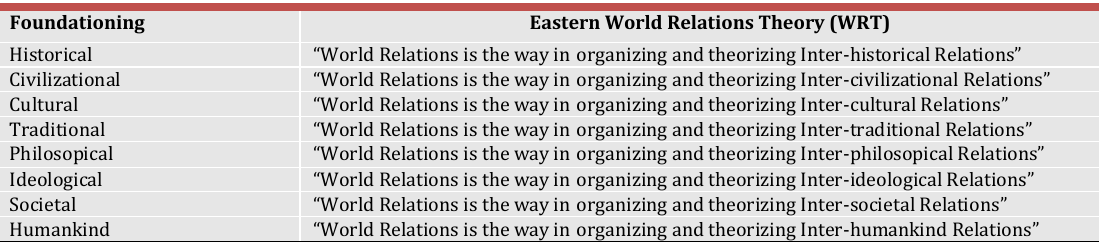
Table 3 Meaning of Eastern World Relations Theory